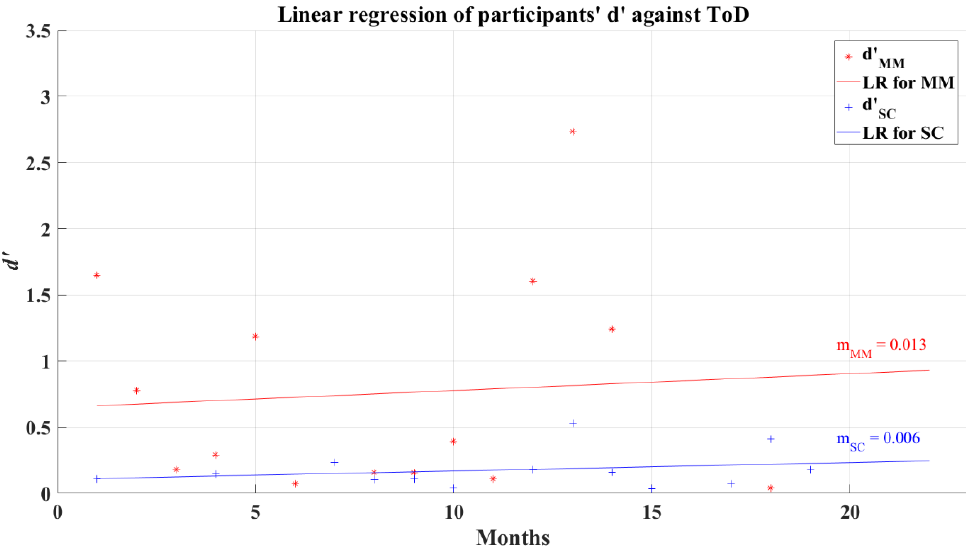
Figure 11. Linear regression for participants’ average d’ and elapsed time of diagnosis for 2AFC-P2. Red line—linear regression for Mild-Moderate post-COVID group (LR for MM); blue line—linear regression for Severe-Critical post-COVID group (LR for SC); 𝑑′ (cid:3014)(cid:3014) , Mild-Moderate group’s efficiency index; 𝑑′ (cid:3020)(cid:3004) , Severe-Critical group’s efficiency index; 𝑚 (cid:3014)(cid:3014) , Mild-Moderate group’s slope; 𝑚 (cid:3020)(cid:3004) , Severe-Critical group’s slope.